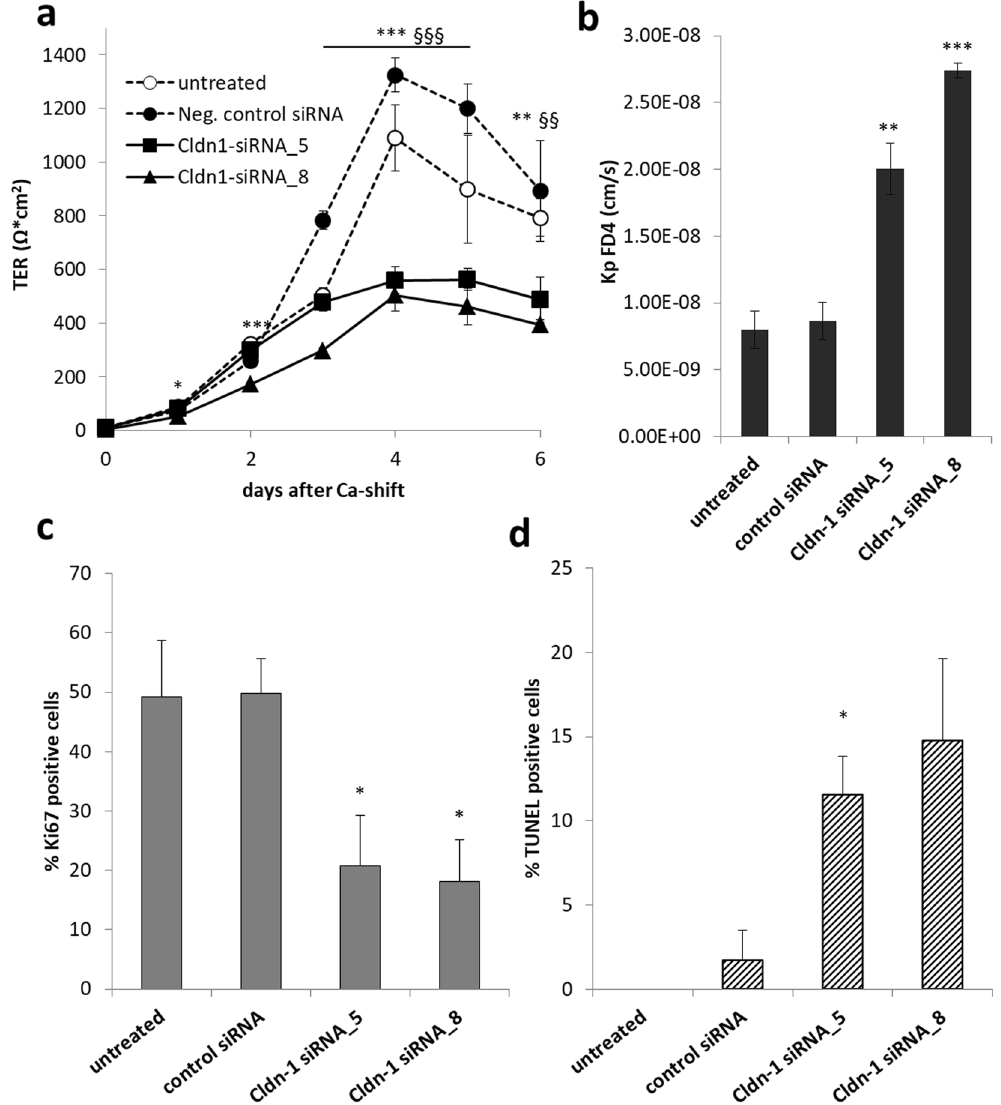
Figure 8. Effect of Cldn-1 KD on barrier function, proliferation and apoptosis in ORS keratinocytes. Representative diagrams showing barrier function to ions (TER, a ) and FD4 ( b ) and percentage of proliferative (Ki67-positive, c ) and apoptotic (TUNEL positive, d ) cells after siRNA mediated KD of Cldn-1 using two different siRNAs (Cldn-1siRNA_5 and _8) and negative control siRNA in cultured ORS keratinocytes. ( a ) TER, means ± SD of 4 wells, n = 3 different donors; significant differences between negative control siRNA cells and cells incubated with siRNA_5 and Cldn-1siRNA_8 are indicated by § and * , respectively. ( b ) Coefficients for FD4 permeations (Kp) at day 4; means + SD of triplicate measurements, n = 3 different donors; * denotes significant differences between Cldn-1 siRNAs and control siRNA. ( c ) Proportion of proliferative (Ki67- positive) cells at day 2 after Ca 2 + -switch expressed as percentage of DAPI-positive cells, ( d ) Proportion of apoptotic (TUNEL-positive) cells at day 4 after Ca 2 + -switch expressed as percentage of DAPI-positive cells. ( c,d ) Means + SD of triplicate measurements, n = 3 different donors; significant differences between cells treated with control siRNA and those treated with either Cldn-1 sIRNA_5 or Cldn-1 sIRNA_8 are indicated by * . Statistical test for all experiments: